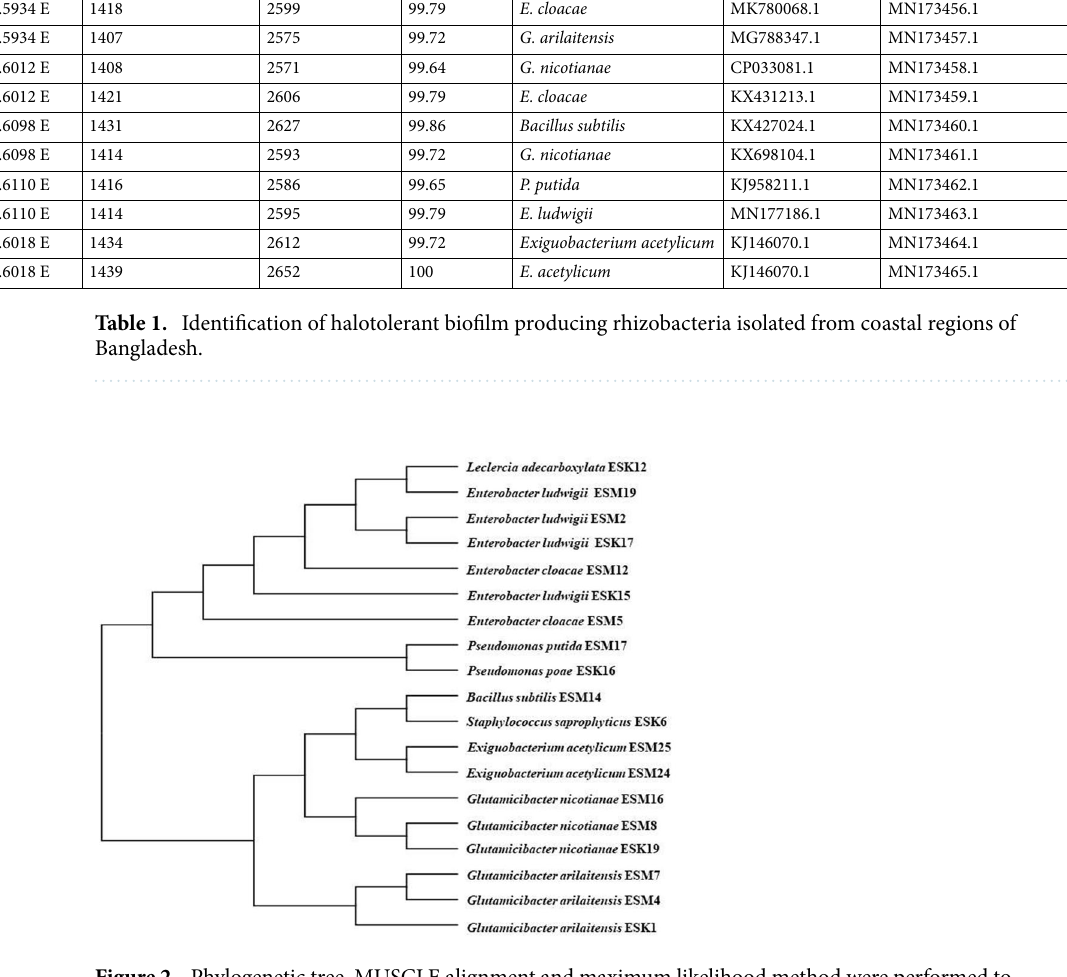
Figure 2. Phylogenetic tree. MUSCLE alignment and maximum likelihood method were performed to construct the tree with Gblock used for alignment